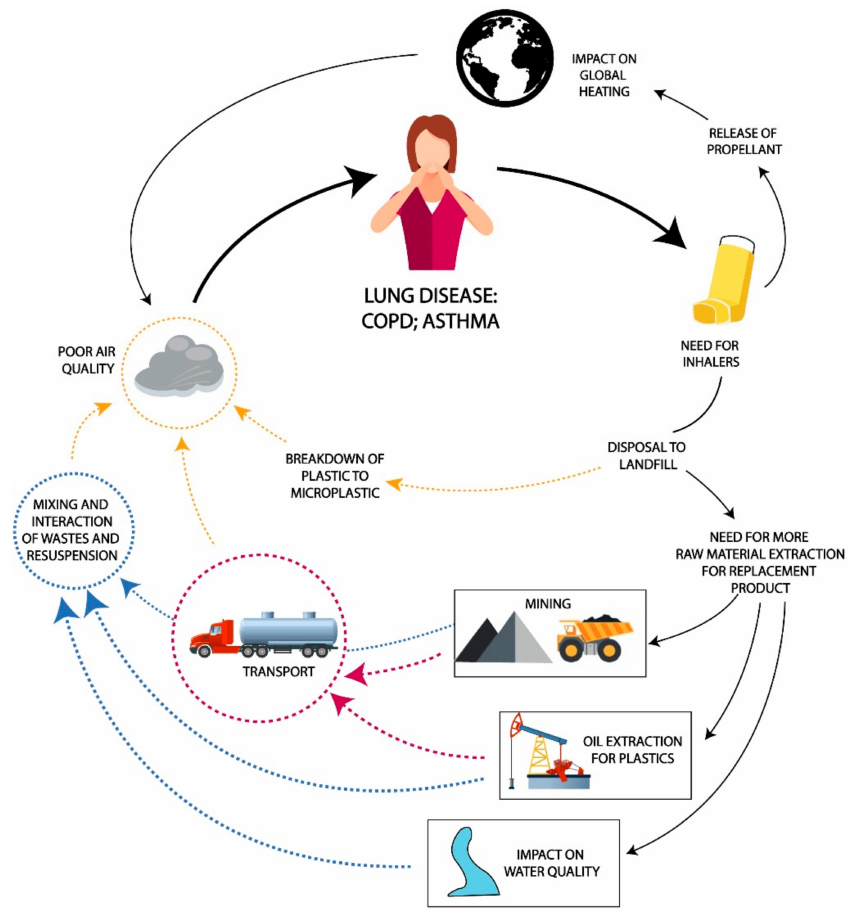
Figure 1. Components of the unnatural cycle of lung disease. Copyright by Lorna